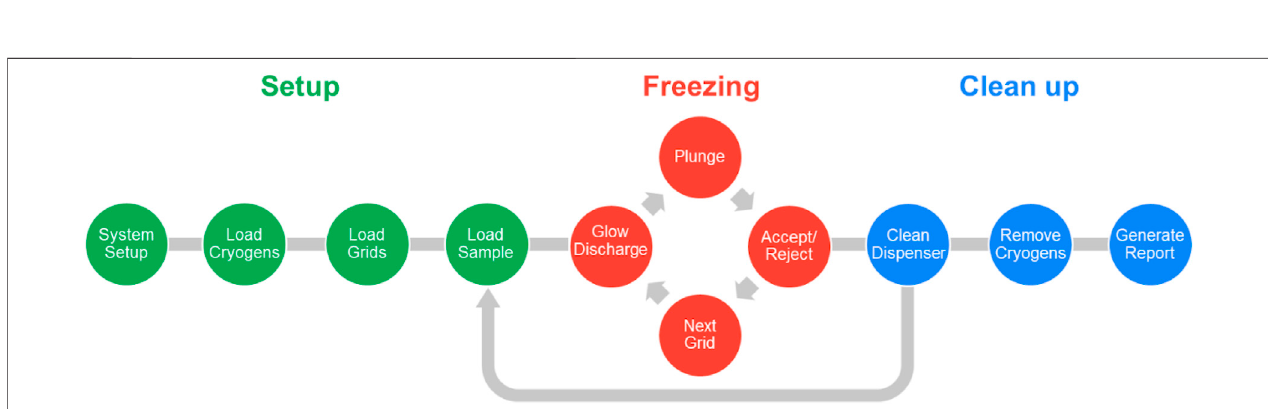
FIGURE 2 | Schematic representation of the chameleon work fl ow. Steps taken to set up the system are indicated in green. The iterative freezing loop (red) cycles between glow discharging, plunging, accepting/rejecting a grid and then moving on to the next. Each freezing session fi nishes with clean up steps (blue); however, if a second sample is to be frozen, it can be loaded into the system within the same session, just after the dispenser has been cleaned.